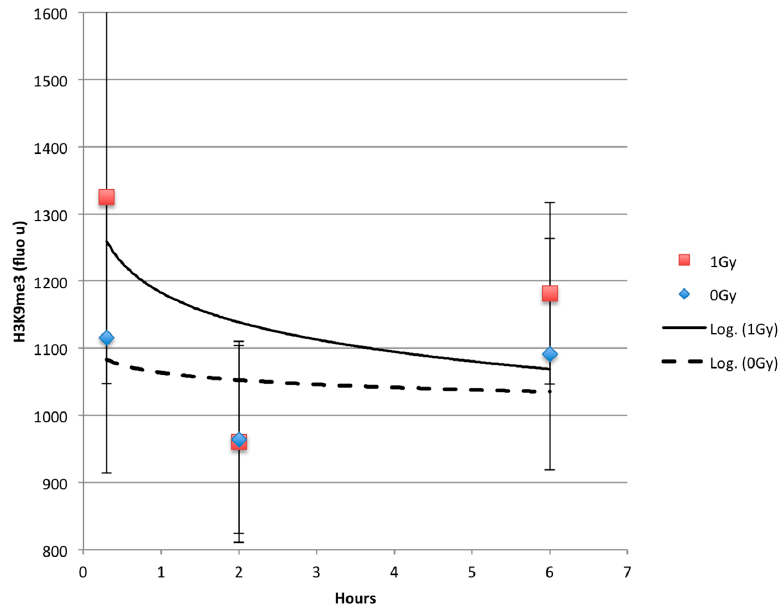
Figure 3. Dependence of staining intensity (arbitrary fluorescent units) from time after exposure to 1 Gy of IR for and sham-exposed (0 Gy) HT1080 cells. Logarithmic regression lines for 1 Gy ( solid ) and 0 Gy ( dashed ) data points are shown.